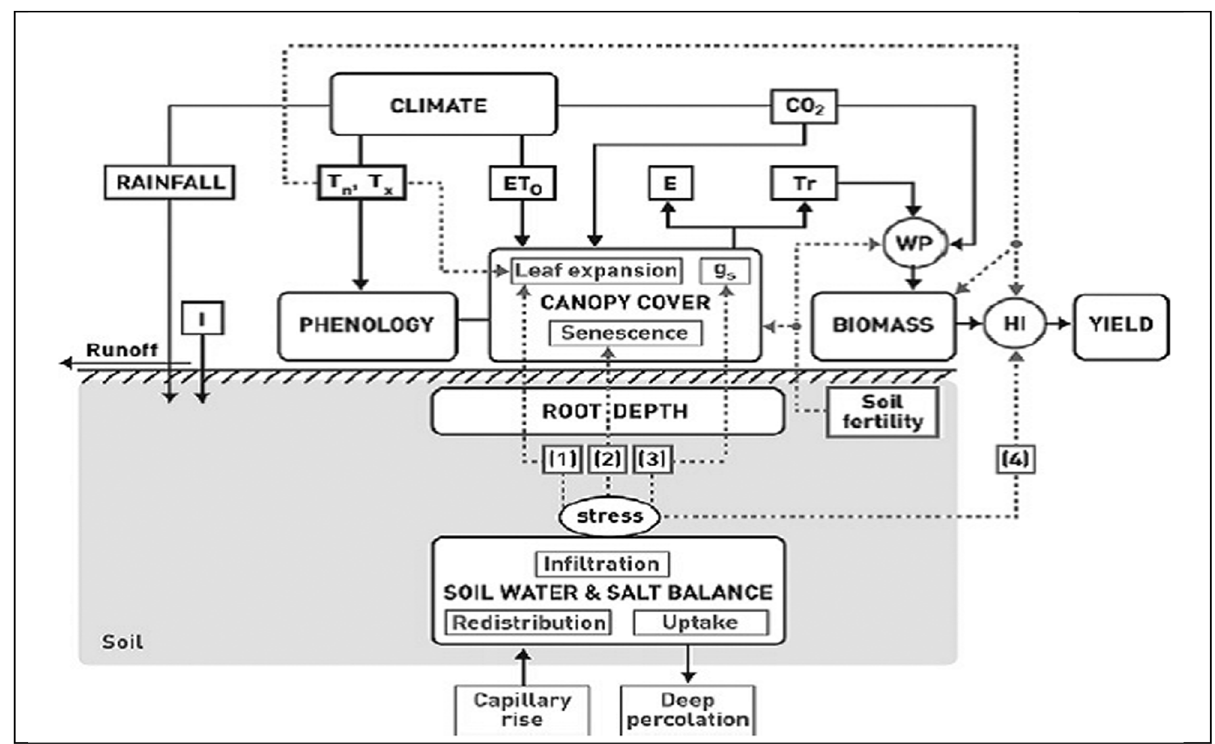
Figure 4: Flowchart of the Aquacrop model ( Steduto et al. 2009 ) . I = irrigation; T n = minimum air temperature; T x = maximum air temperature; ETo; soil evaporation; T r = canopy transpiration; WP = water productivity; HI = harvest index.